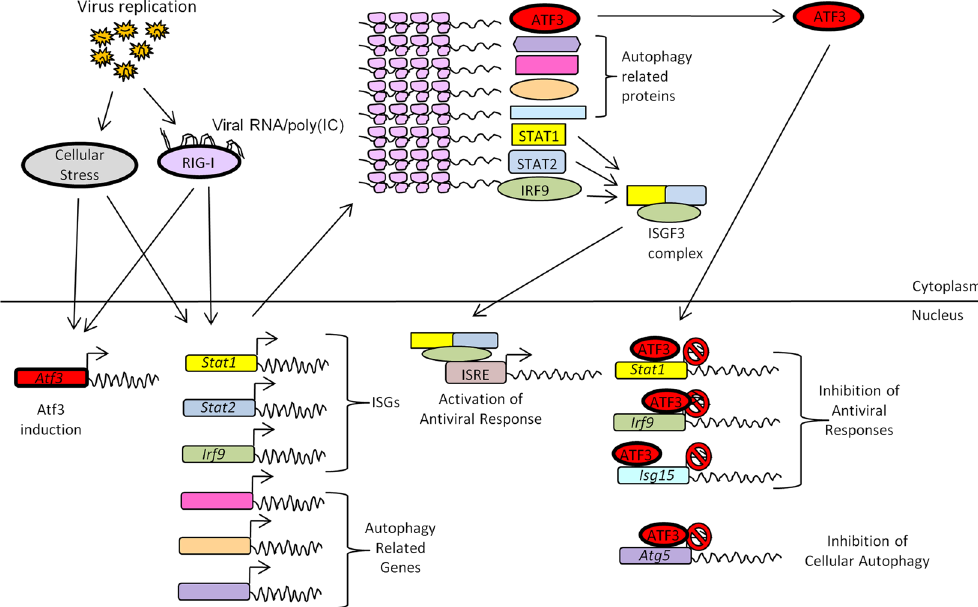
Figure 9. Mechanistic model for ATF3-mediated negative regulation of antiviral and autophagy pathways in the absence of type I IFN. Shown above are the antiviral and autophagy pathways that are triggered following the virus infection of a mammalian cell. Our study shows that ATF3 induced during JEV infection can bind to the promoter region of Stat1, Irf9 , Isg15 to suppress the antiviral signaling. We also show ATF3 binding to Atg5 promoter, thereby suppressing the cellular antiviral pathway. The ATF3, thus, negatively regulates the cellular antiviral signaling and autophagy pathway in the absence of type I